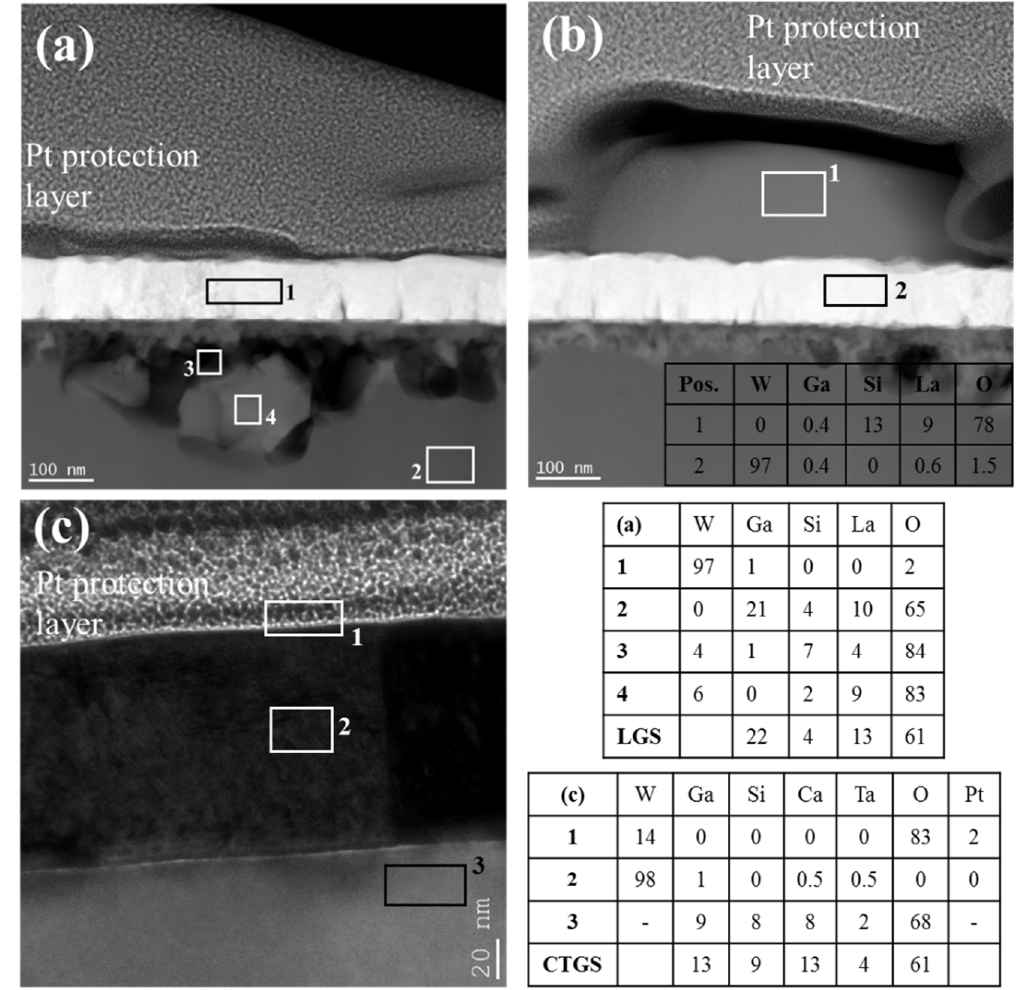
Figure 5. TEM images along with the composition (table inset) of the marked regions obtained by EDX analysis of ( a ) W ‐ LGS; ( b ) W ‐ LGS showing the blister; and ( c ) W ‐ CTGS.